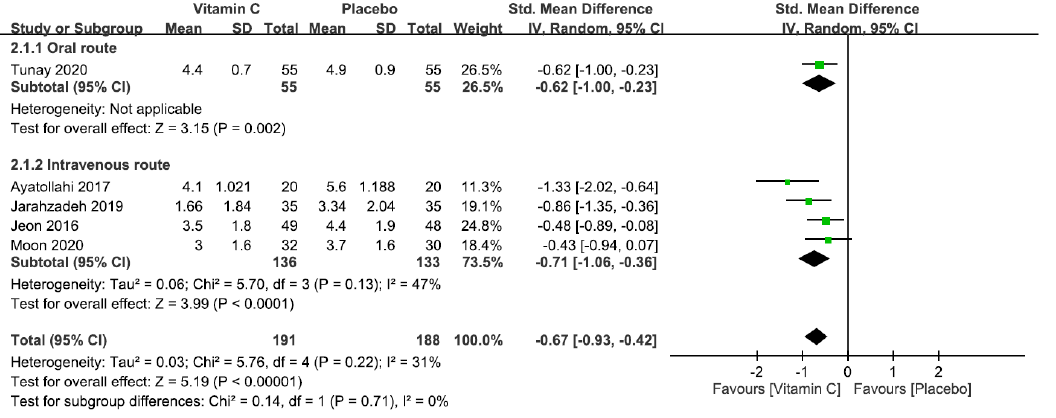
Figure 5. Forest plot for the comparison of pain severity 6 h after surgery between vitamin and placebo groups. CI, confidence interval; IV, inverse variance; Std., standardized.